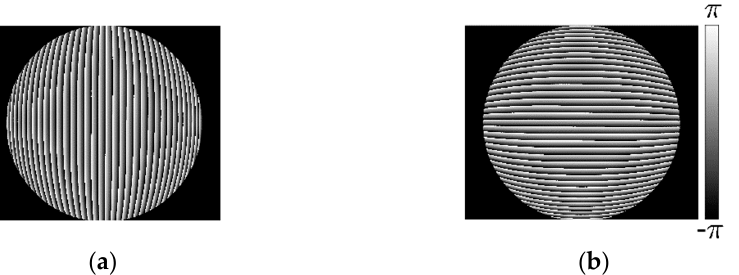
Figure 12. Wrapped phase. ( a ) Wrapped phase of distorted longitudinal fringe-pattern; ( b ) Wrapped